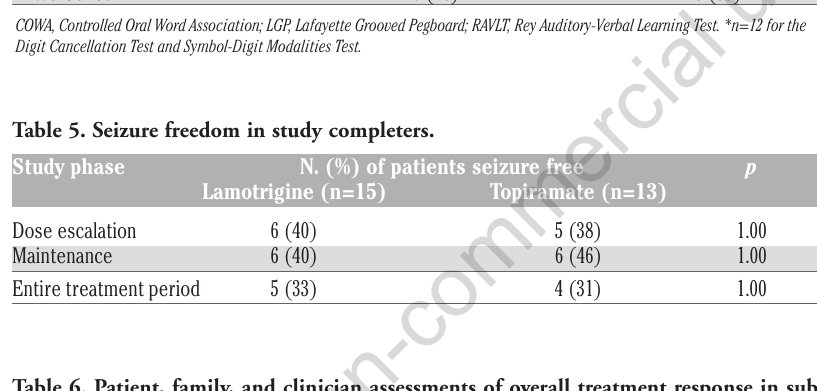
Table 6. Patient, family, and clinician assessments of overall treatment response in sub- jects who completed the study.